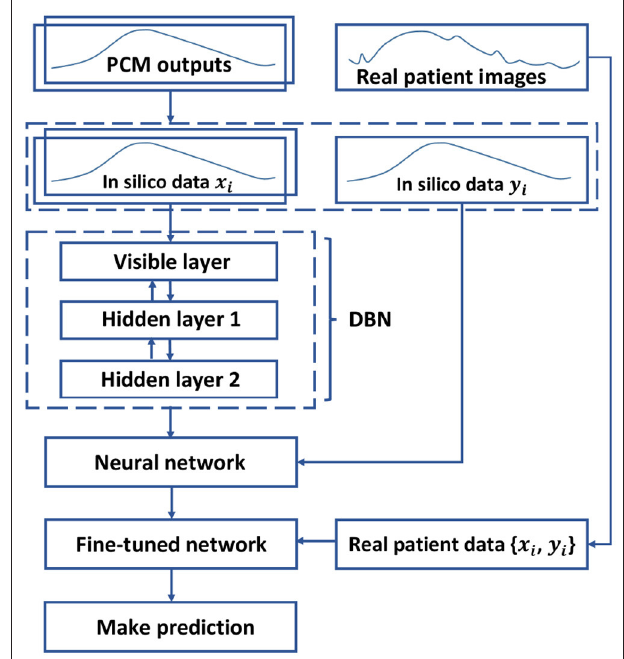
FIGURE 5 | Diagram of the model training. The DBN is pre-trained by in silico data in an unsupervised manner, and is unfolded into a neural network. Next, the neural network is fine-tuned with the patient data in a supervised manner to predict the AAA expansion.